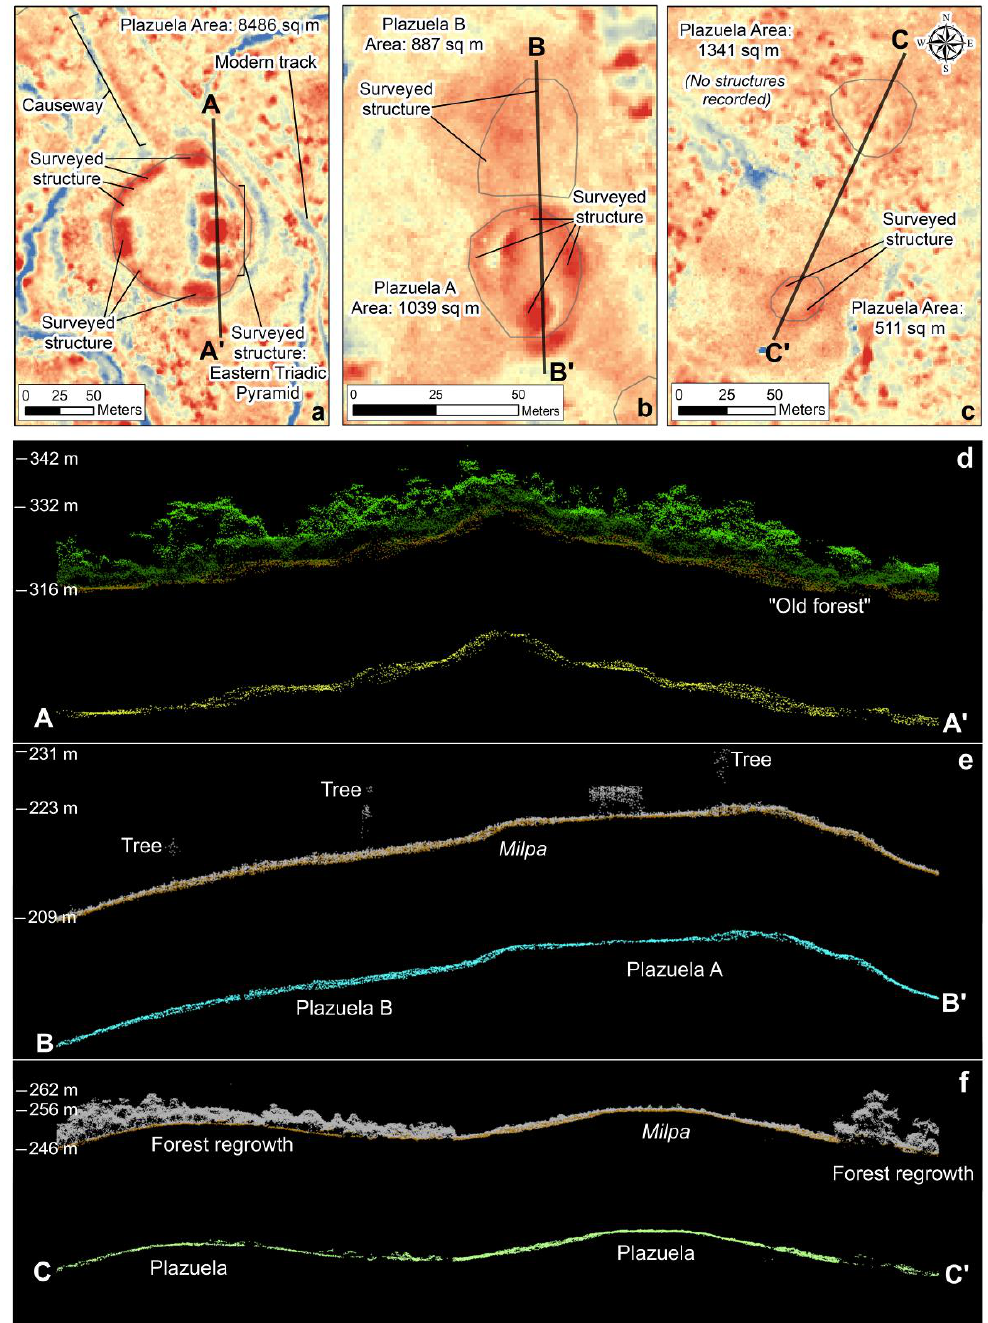
Figure 8. A comparison of ( a ) large, ( b ) medium, and ( c ) medium and small plazuelas. Larger plazuelas and structures on them (indicated on the maps) tend to be more visible than smaller plazuelas and associated structures. However, these relationships are not always consistent, as vegetation cover and structure size also impact the ability to detect archaeological features. Plazuela outlines are in gray on the SLRM raster background. ( d – f ) Point-cloud profiles of images ( a – c ) showing all (point) returns (upper profiles; filter: classification; gray and green = vegetation; orange = ground return) and ground returns (lower profiles; filter: elevation). Elevations are marked on the left of the all returns point cloud profiles, indicating the lowest elevation (bottom elevation), highest ground elevation (middle elevation), and highest vegetation elevation (upper